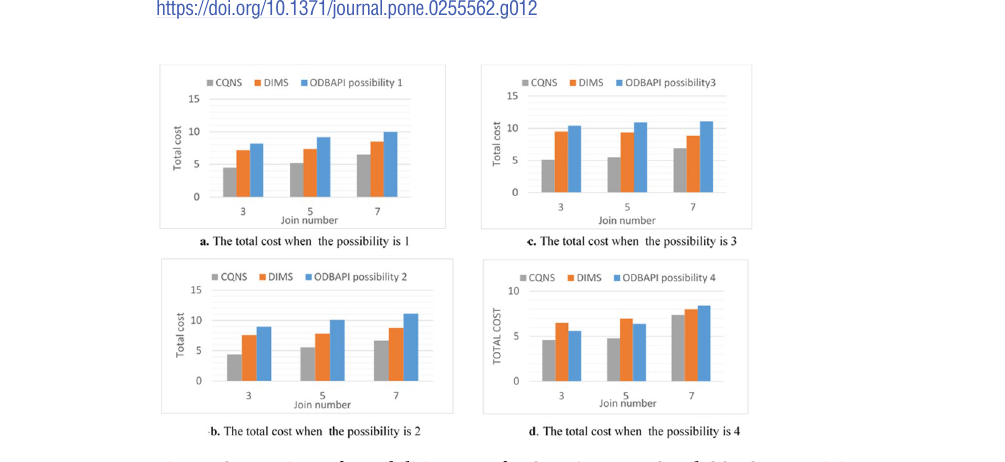
Fig 13. Comparison of possibilities 1 to 4 for ODBAPI, DIMS and CQNS on star joins.